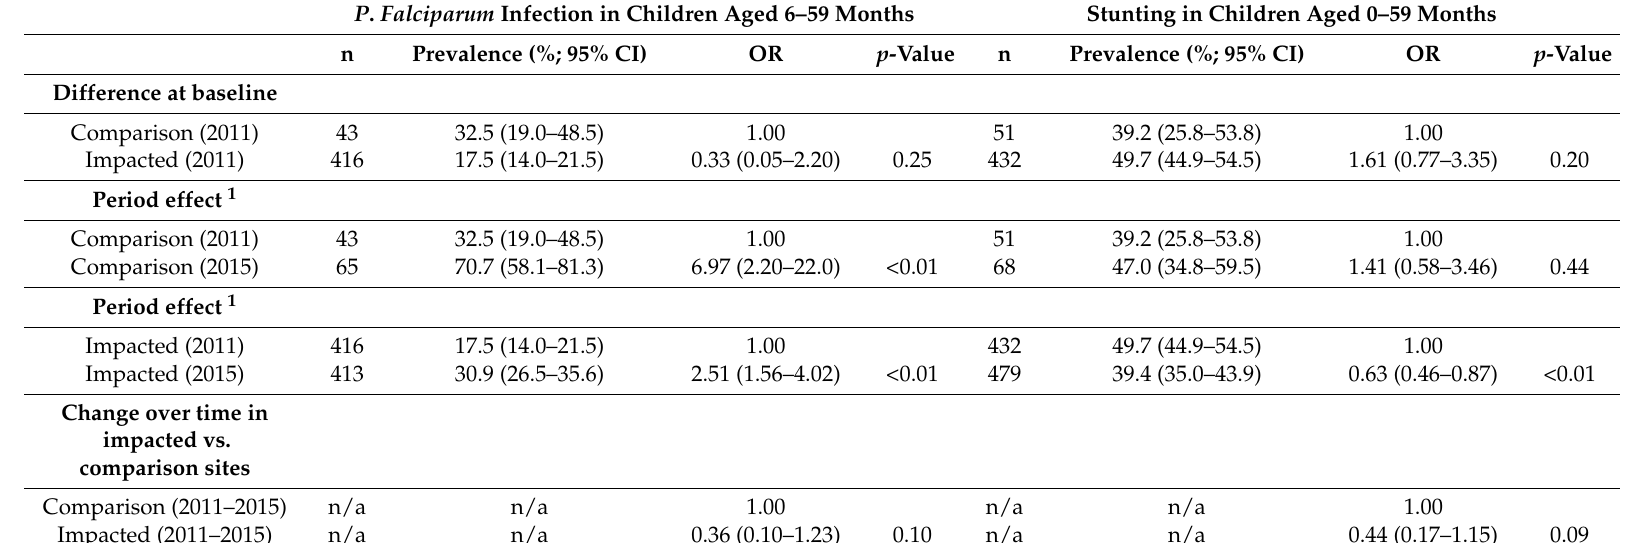
Table 3. Prevalences and period effects for P . falciparum infection and stunting, Trident project, 2011 and 2015,